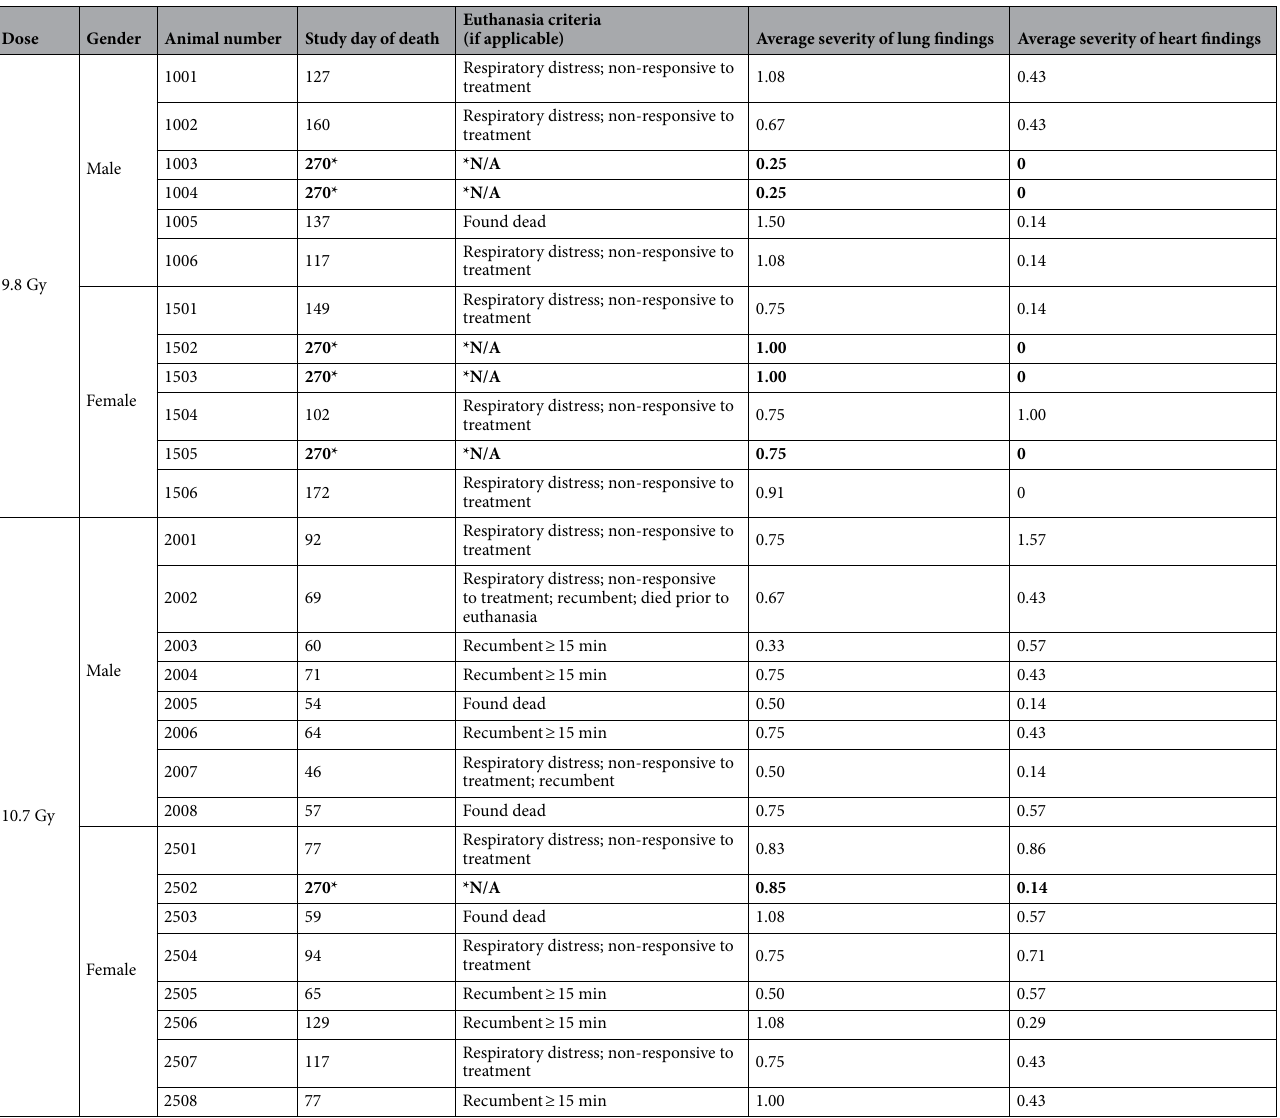
Table 1. Study day of death, euthanasia criteria (if applicable), and average lung and heart severity of findings scores for each animal included in the study. Bold typeface indicates data for the six animals that survived the length of the study. *Animal survived the length of the study (270 days) and was euthanized when study terminated. Criteria for lung and heart severity score are noted in Methods